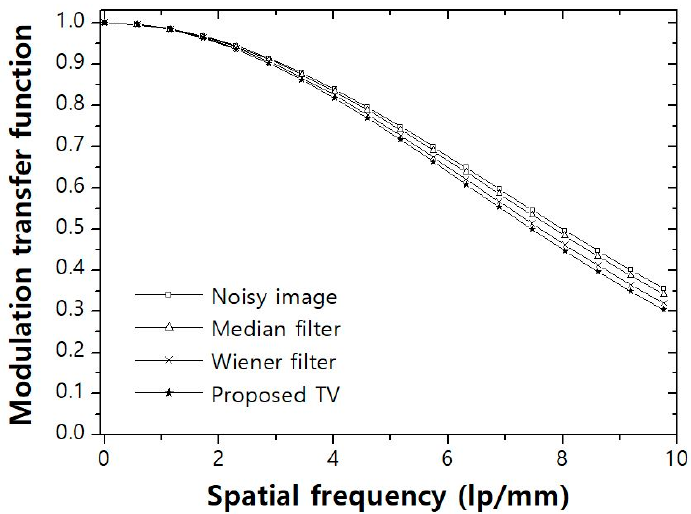
Figure 6. Modulation transfer function (MTF) results obtained for the noisy image, median filter, Wiener filter, and proposed TV noise reduction algorithm applied to the confocal laser scanning micrograph of the tooth specimen.